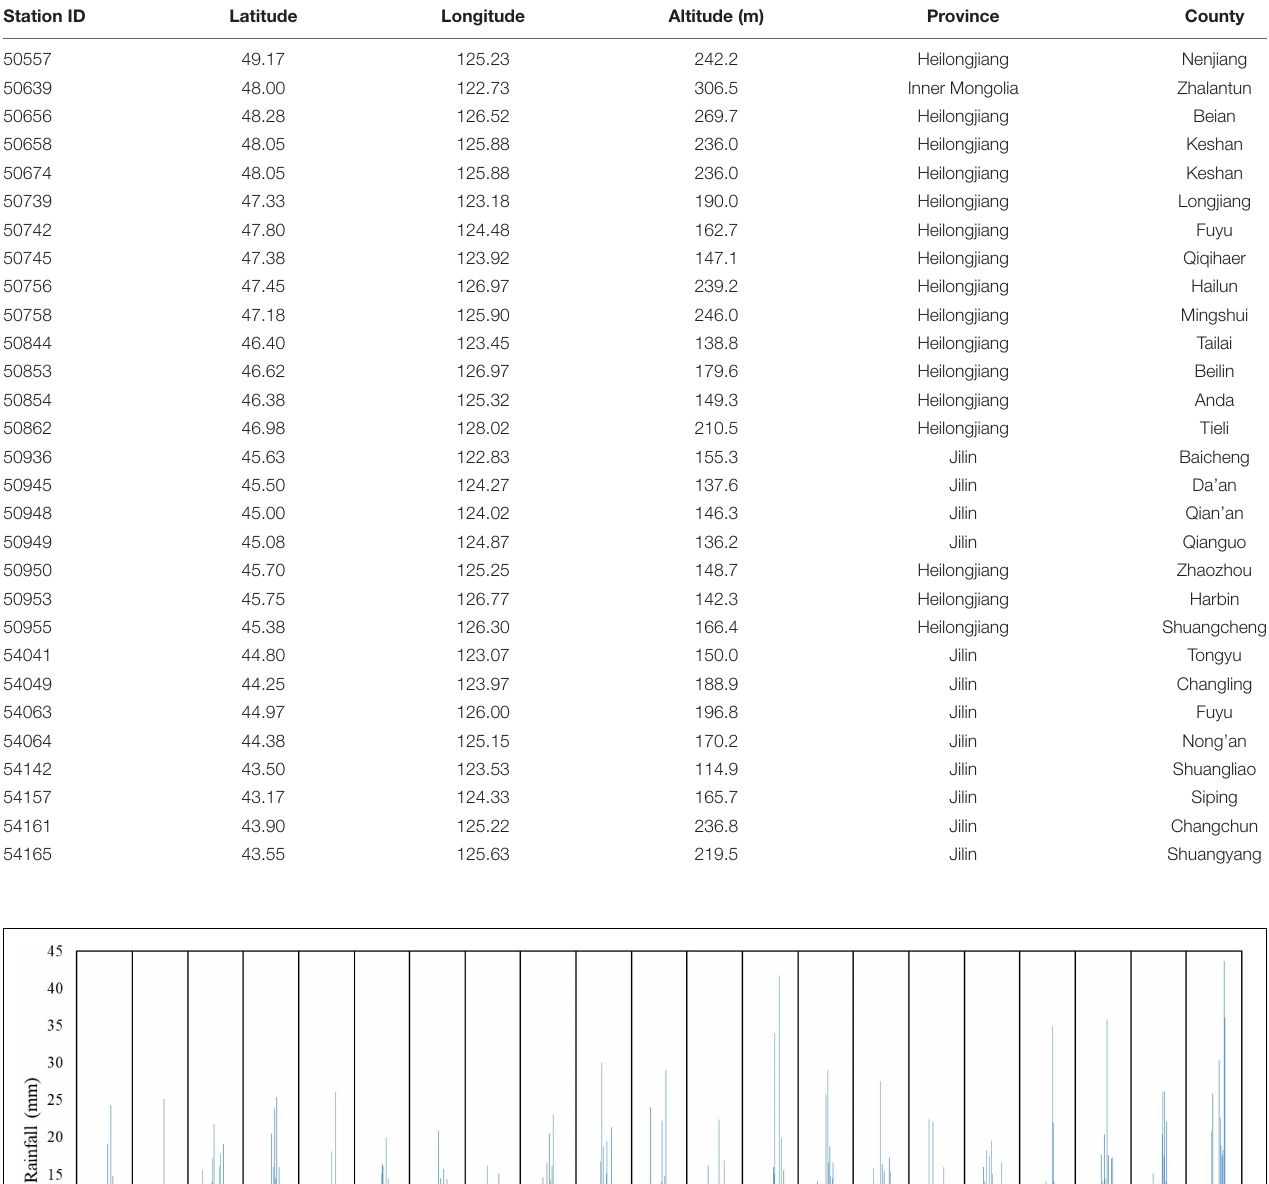
TABLE A1 | Weather station information in Songnen Plain.